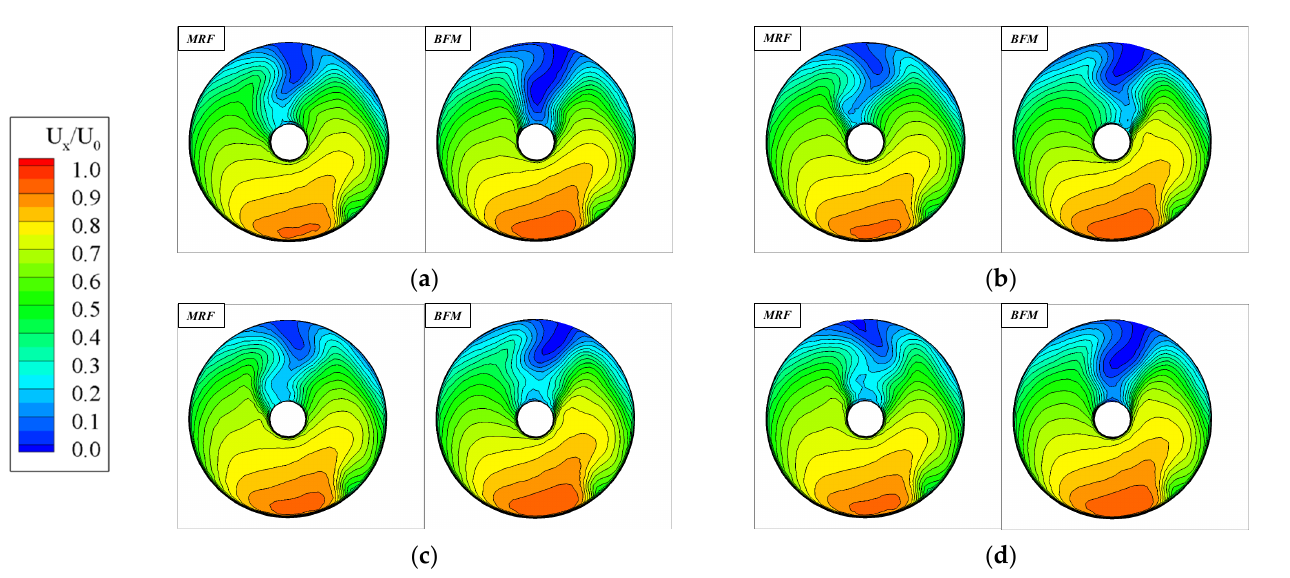
Figure 16. Comparison of non-dimensional axial velocity distribution of the MRF model and body- force model (BFM) at station 3. ( a ) Fr = 0.3; ( b ) Fr = 0.4; ( c ) Fr = 0.5; ( d ) Fr = 0.542.